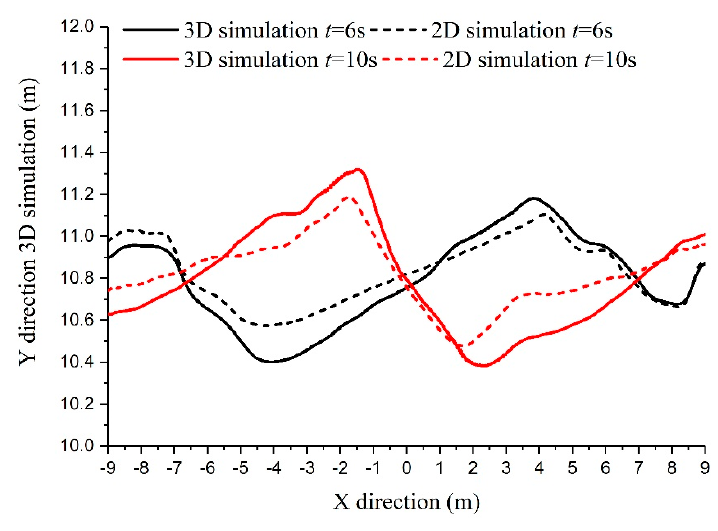
Figure 9. Free surface response at selected moments.